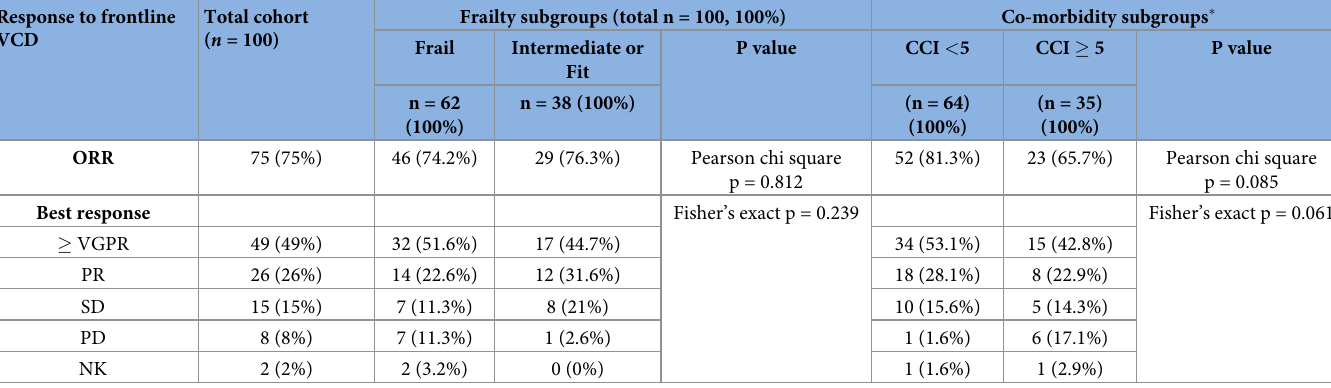
Table 3. Response rates to first line VCD myeloma therapy in the total cohort, in MRP subgroups (frail vs. intermediate or fit) and in co-morbidity subgroups. Response to frontline